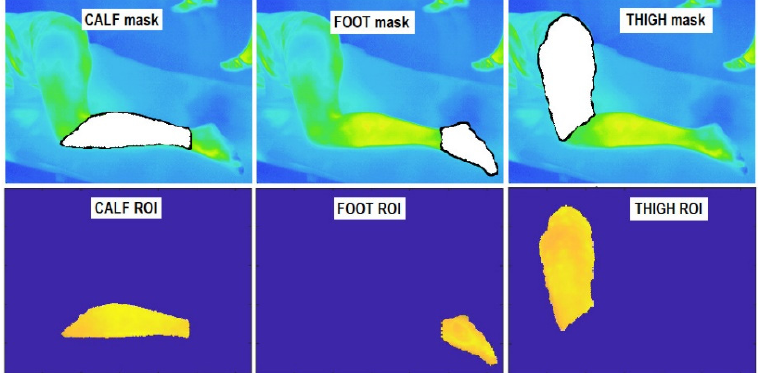
Figure 2. The result of the manual procedure ( upper line ) and the visualization of the matrices for the three ROIs ( lower line ) . the three ROIs ( lower line